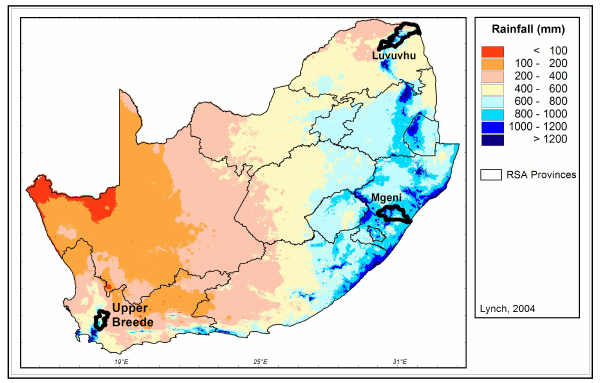
Fig. 2. Location of the study catchments superimposed on a map of the mean annual precipitation (MAP) of South Africa (MAP after Lynch, 2004).